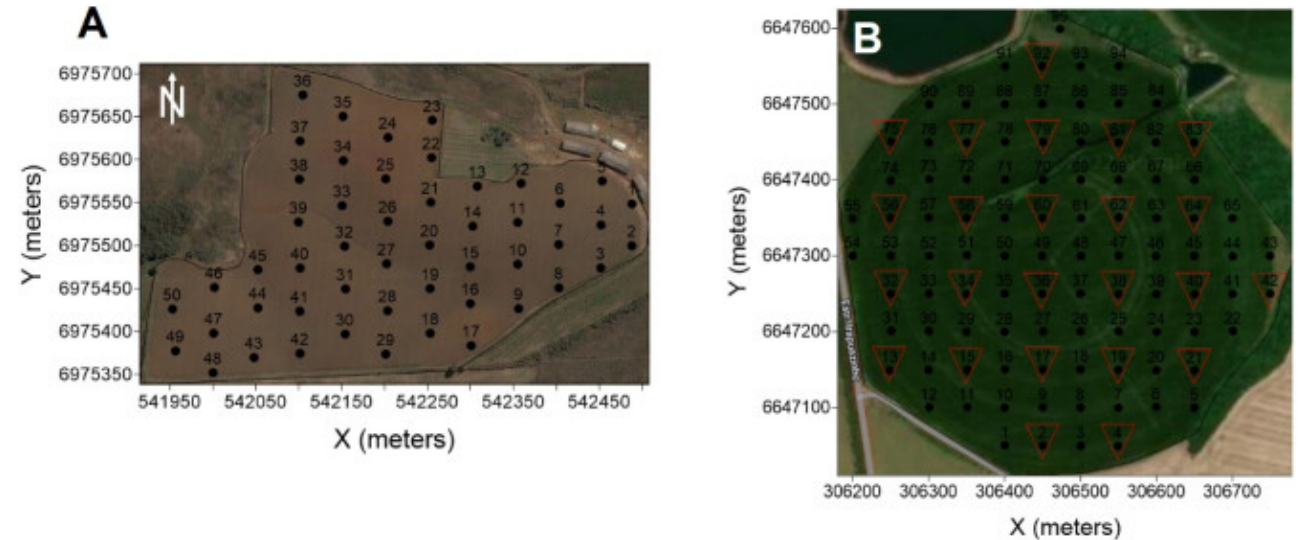
Figure 2. Representative map of experimental areas and sampling points. Field classified with clay texture ( A ) located in Curitibanos/SC (Field C) and field classified with sandy clay loam texture ( B ) located in Cachoeira do Sul/RS (Field SCL). Triangle in ( B ) indicates soil sampling.